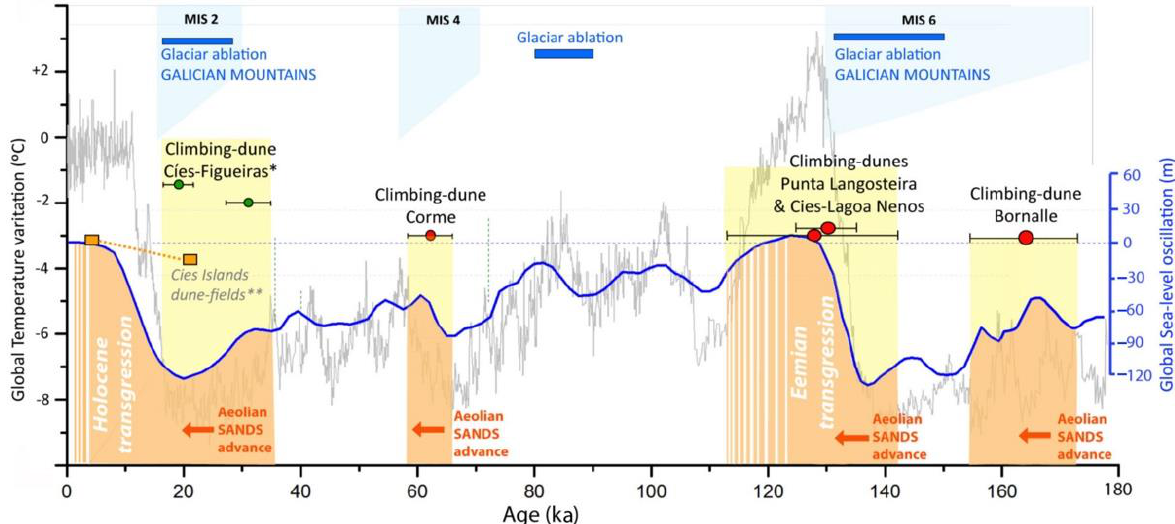
Figure 6. 180 ka global climatic record and the formation age of the coastal climbing dunes dated by pIR-IRSL. The global temperature variation from Vostok ice cores [38], global sea level oscillation [40] and cold marine isotope stages (MIS6, MIS4 and MIS2) [39]. The formation ages (and error) for the coastal climbing dunes from Punta Langosteira, Corme, Bornalle and Lagoa dos Nenos. The figure also shows the formation age of the climbing dune from Figueiras, in the Cíes Islands-, dated from 35 ka to 17 ka by OSL [8], the formation age of the current dune fields on the Cíes Islands dating back 25 ka to 4 ka [9] and the episodes of glacier ablation in the mountains of Galicia (NW Spain) [42,43]. (Punta Langosteira) on the present-day coastline between +5 m and +9 m (apsl)